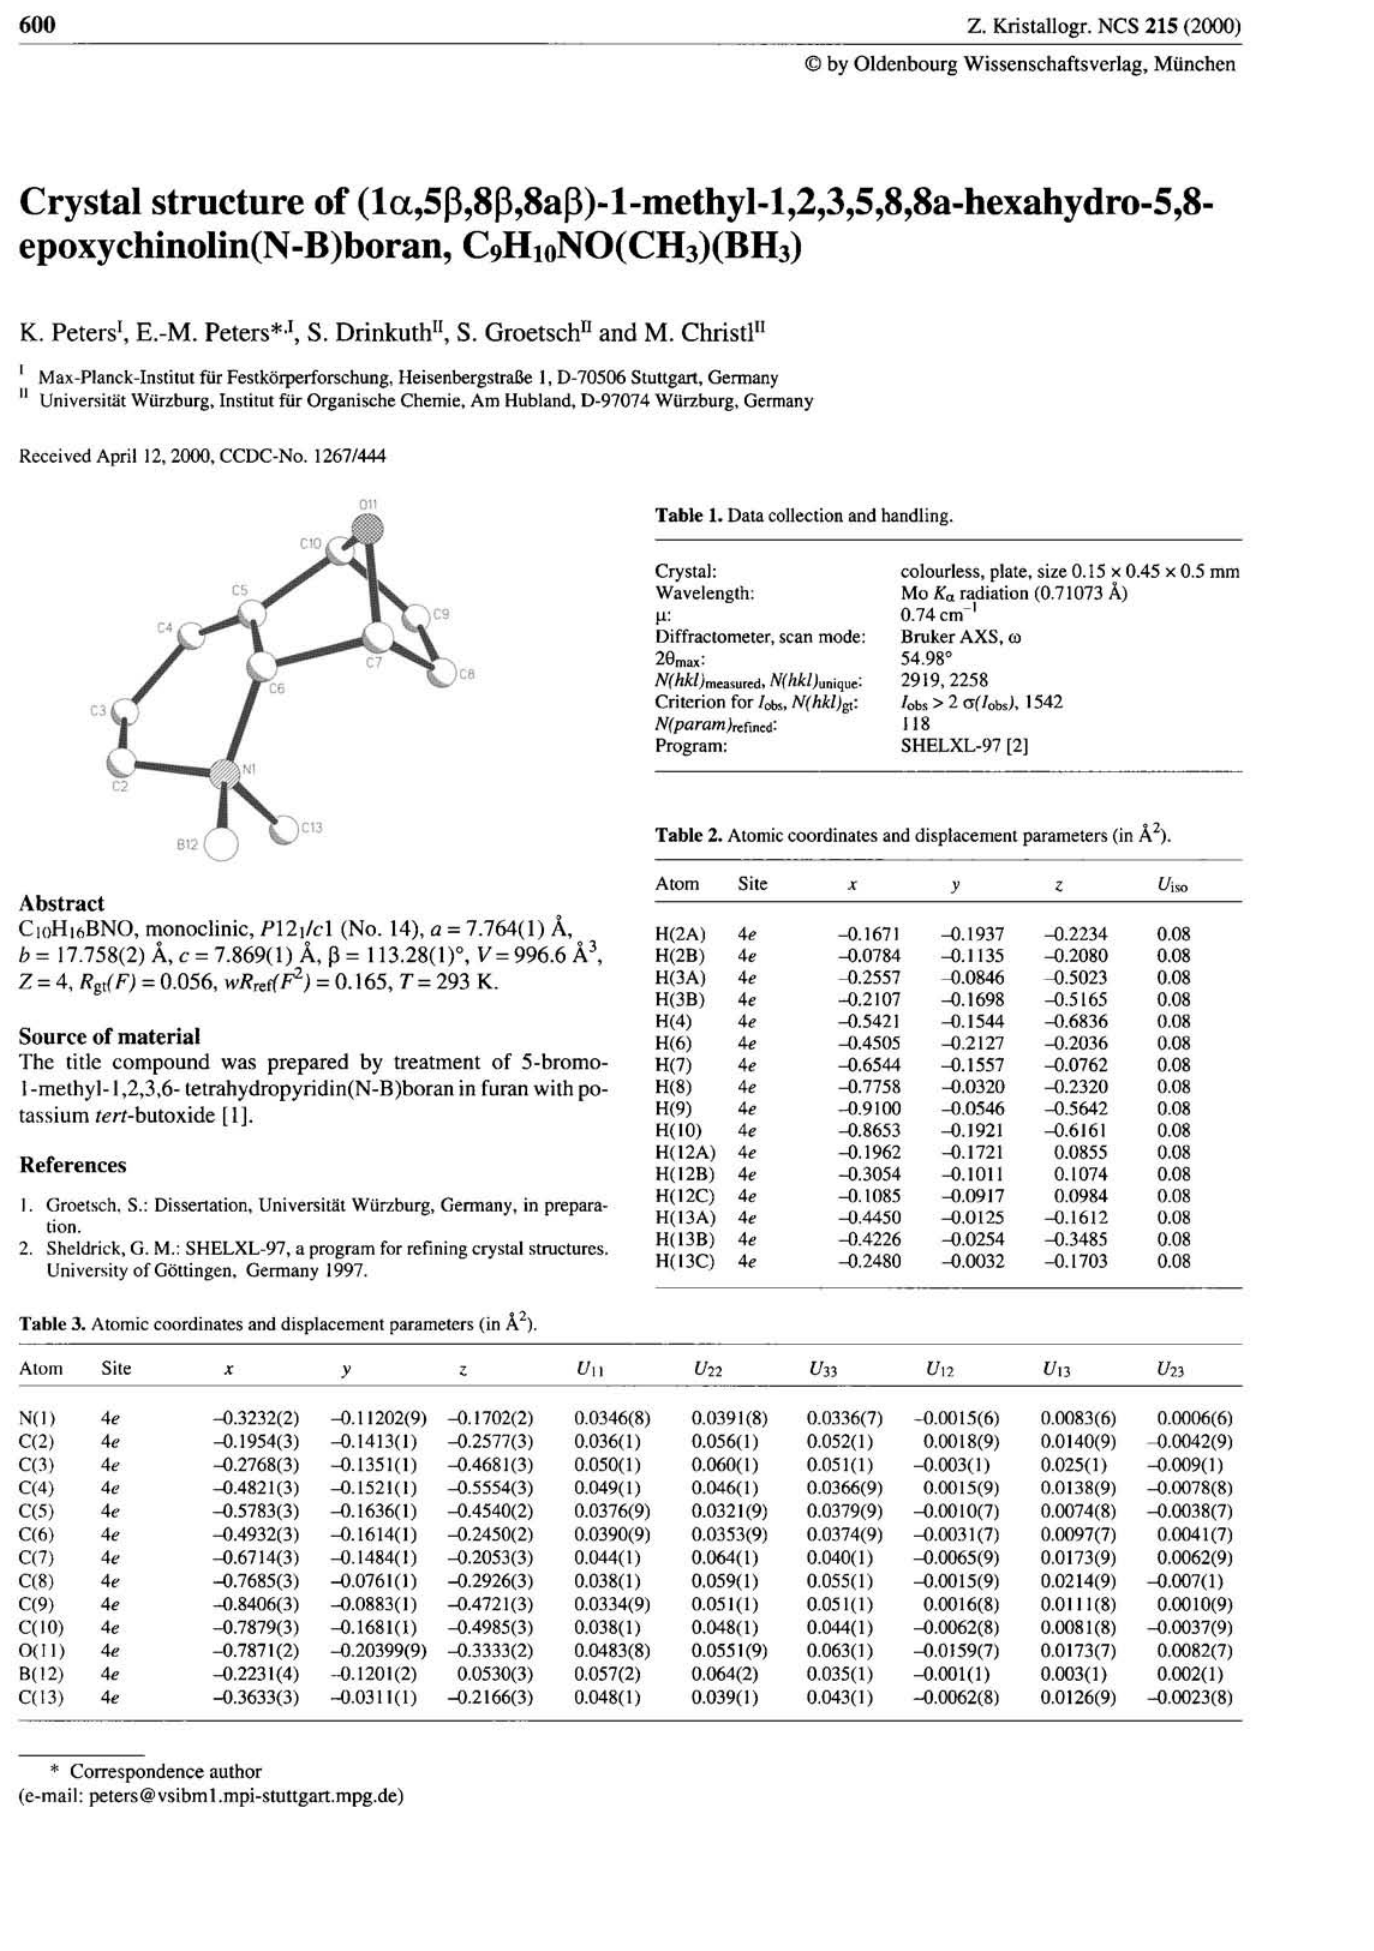
Table 3. Atomic coordinates and displacement parameters (in Â 2 ).